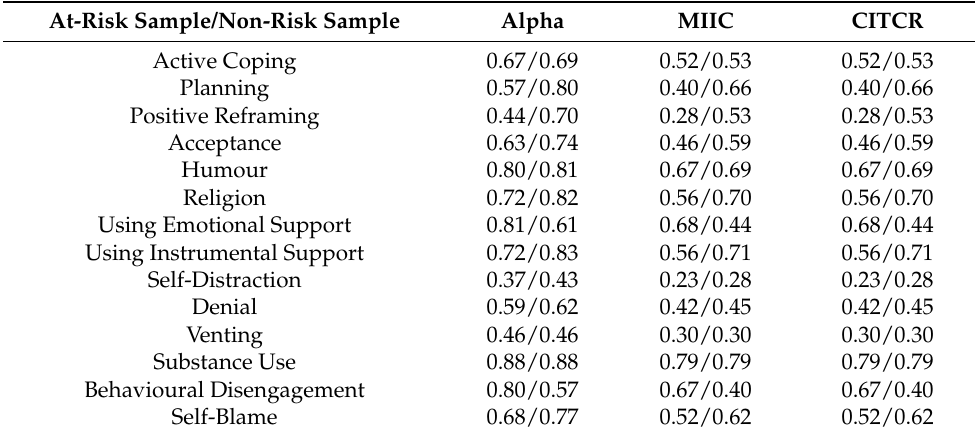
Table 5. Internal consistency of Brief COPE.